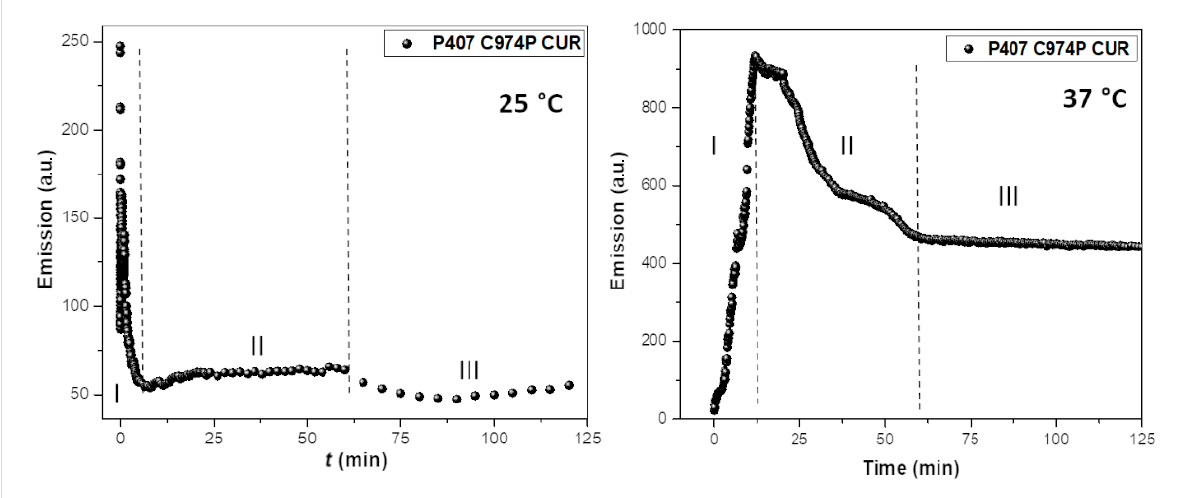
Figure 2: Incorporation kinetic profiles of systems containing poloxamer 407 (P407), Carbopol 974P (C974P) and curcumin (CUR) obtained at 25 °C and 37